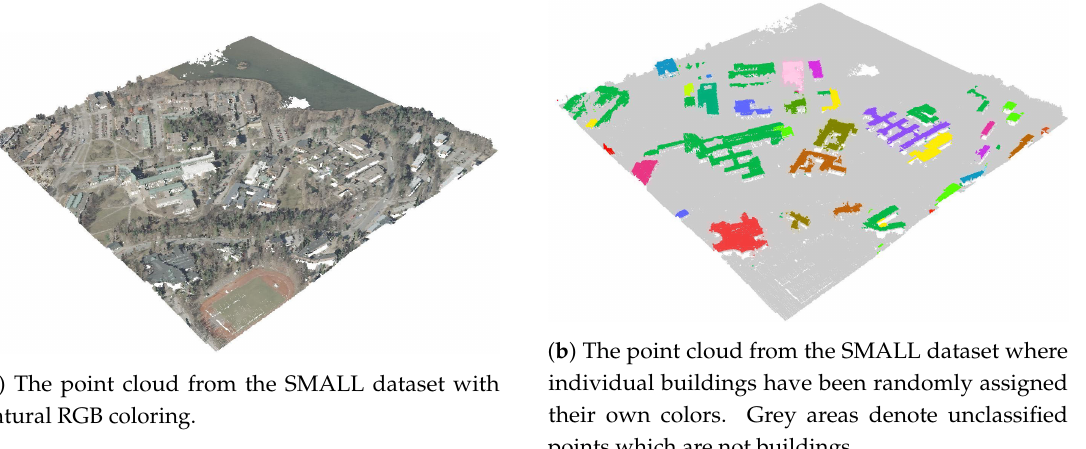
Figure 1. The point cloud visualization for the SMALL dataset representing a collection of buildings in the Otaniemi district that is part of the Espoo municipality in Finland. The dataset was produced from the openly available, classified airborne laser scanning (ALS) point cloud provided by the Finnish National Land Survey [66], by obtaining a unique building ID for all points in a building from the topographic database [67] via spatial correlation using the QGIS application (Version 2.18.12). The ALS point cloud was then manually segmented for Otaniemi and downsampled to produce the final point cloud. The semantic ID is only used to denote specific buildings (all other points are assigned a value of 0), which number a total of